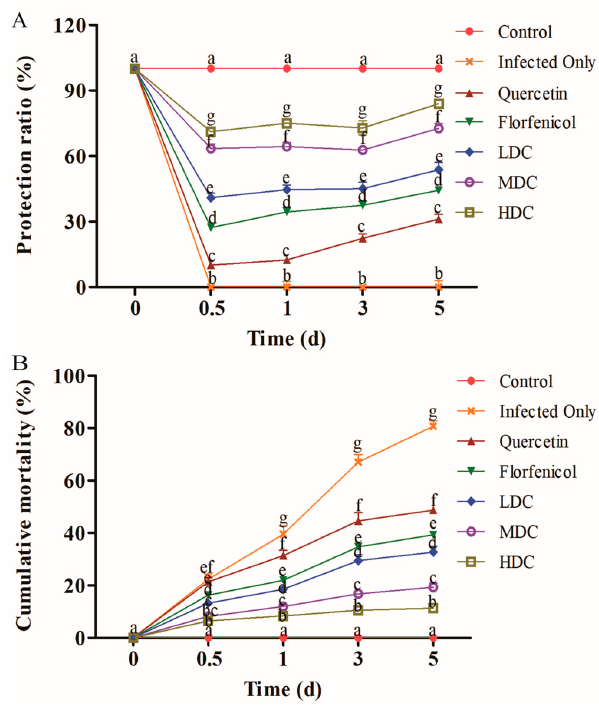
Figure 1. The ( A ) protection rates and ( B ) cumulative mortality of VP AHPND -infected L. vannamei in each experimental group at different times after drug treatment. One-way ANOVA and Duncan’s multiple range test were used to analyze the significant differences among different groups, and different letters represent significant differences between groups ( p < 0.05).